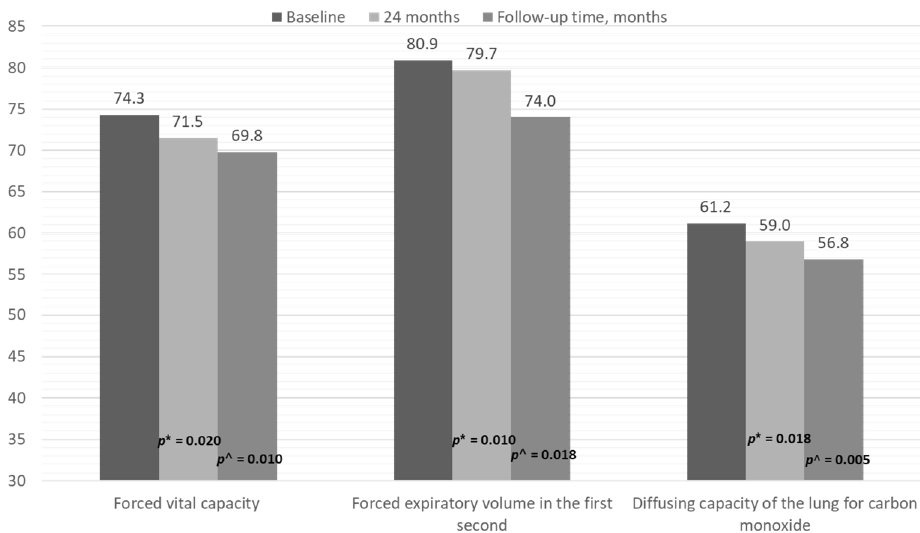
Figure 2. Progression of pulmonary function test results at the end of follow-up in patients with RA and ILD receiving DMARDs. * p -value for the comparison between 24 months and baseline; ^ p -value for the comparison between end of follow-up and baseline.